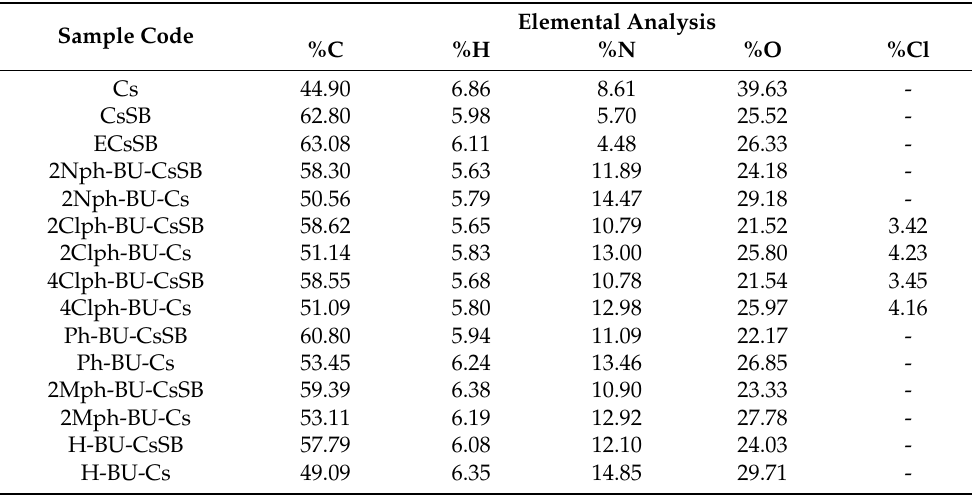
Table 1. Elemental analysis of the R-BU-CsSB and R-BU-Cs